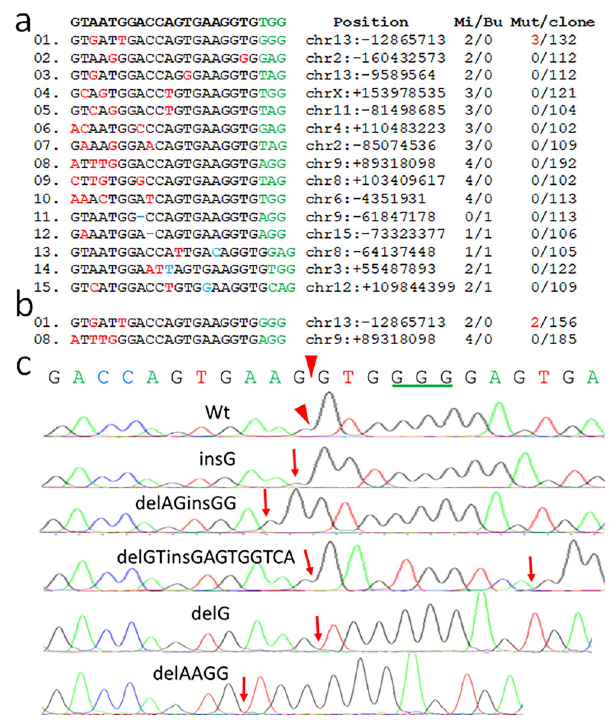
Fig. 4 Off-target editing events in the G1H/Cas9 mice. a, b hSOD1 sequence for Cas9 gRNA is on the top. DNA sequence, chromosomal position, number of nucleotide mismatch and bulge (Mi/Bu), and number of the identi fi ed mutants among the total number of the sequenced clones (Mut/clone) in 15 genome-wide potential off-target sites are shown. PAM sequences are shown in green. Nucleotide mismatches are shown in red. Nucleotide in blue indicates DNA bulge and ( − ) in blue indicates RNA bulge. Two G1H/Cas9 mice were analyzed (#8190, 585 days: a ; #7449, 196 days: b ). c Editing events identi fi ed in off-target #1. Arrowheads indicate the Cas9 cleavage site in off-target #1. Individual edited events are labeled on the top of sequencing chromatograms. Among 132 clones, three mutant clones were identi fi ed (delG, delAGinsGG, and delGTinsGAGTGGTCA) in mouse #8190, and among 156 clones, two mutant clones were identi fi ed (delG and delAAGG) in mouse #7449. The sites of mutations are indicated by